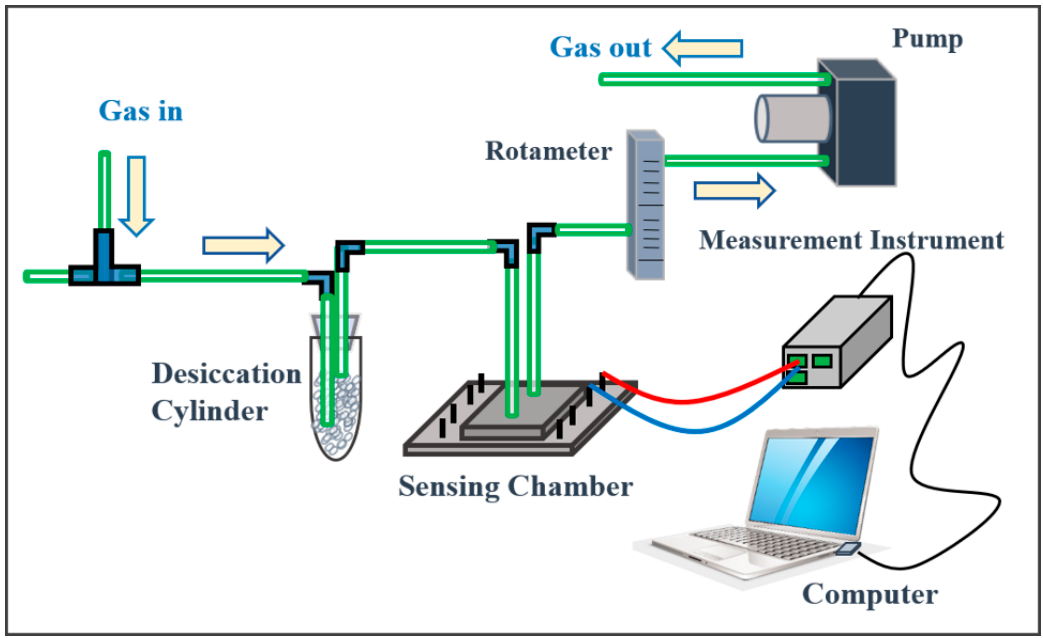
Figure 1. The sensing system includes a desiccation cylinder, an airtight sensing chamber, a rotameter, a pump, and an electrical signal measurement instrument (Keysight U2722A USB Modular Source Measure